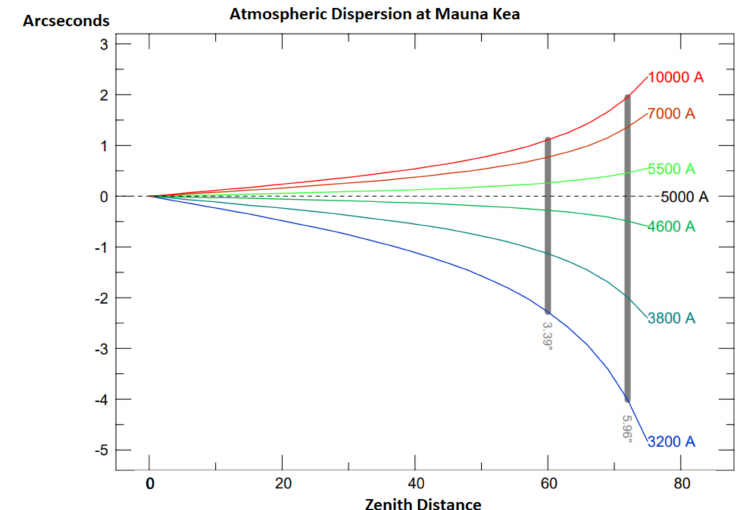
Figure 1. Representative atmospheric dispersion, as a function of zenith distance in degrees, calcu- lated for Keck at Mauna Kea. The indicated values from primary dispersion at 60 and 70 degrees zenith distance highlight the nonlinear nature of atmospheric dispersion, as the magnitude of primary dispersion almost doubles in the last 14% of the indicated zenith distance